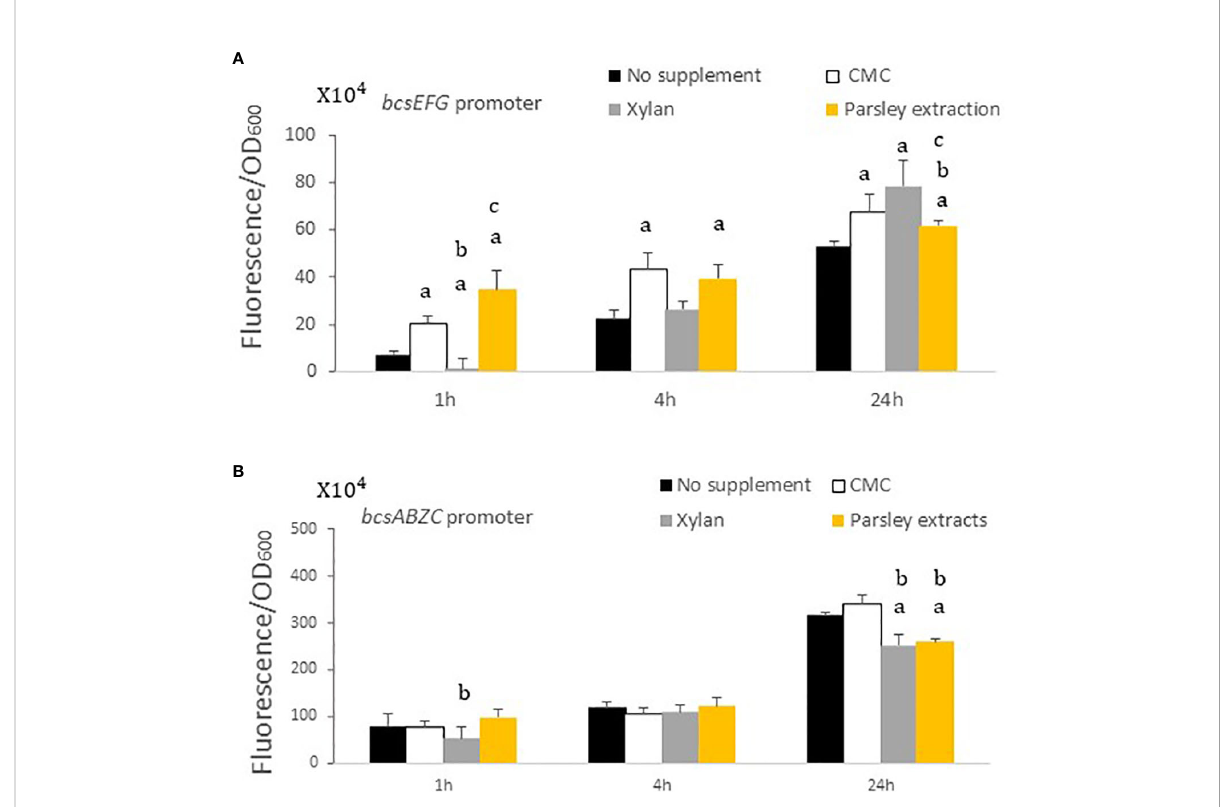
FIGURE 3 The effects of plant components on the bcsEFG and bcsABZC expression. S . Typhimurium containing a plasmid with either bcsEFG or bcsABZC promoter fused upstream to a gfp gene was grown in minimal medium in the presence of CMC, xylan or parsley extracts. The fl uorescence was measured 1, 4 and 24 hours post polysaccharides addition. (A) Normalized fl uorescence measurements of GFP with bcsEFG as promoter in the presence of CMC, xylan and parsley extracts. (B) Normalized fl uorescence measurements of GFP with bcsABZC as promoter in the presence of CMC, xylan and parsley extracts. Mean values of four experiments, each one was conducted in triplicates, are presented. Error bars represent standard deviations. Statistical calculations are represented as a, b and c when “ a ” de fi nes the signi fi cance difference between no supplement to other treatments at the same time point, “ b ” de fi nes CMC to other treatments and “ c ” de fi nes the difference between xylan and parsley extracts. P ≤ 0.05.